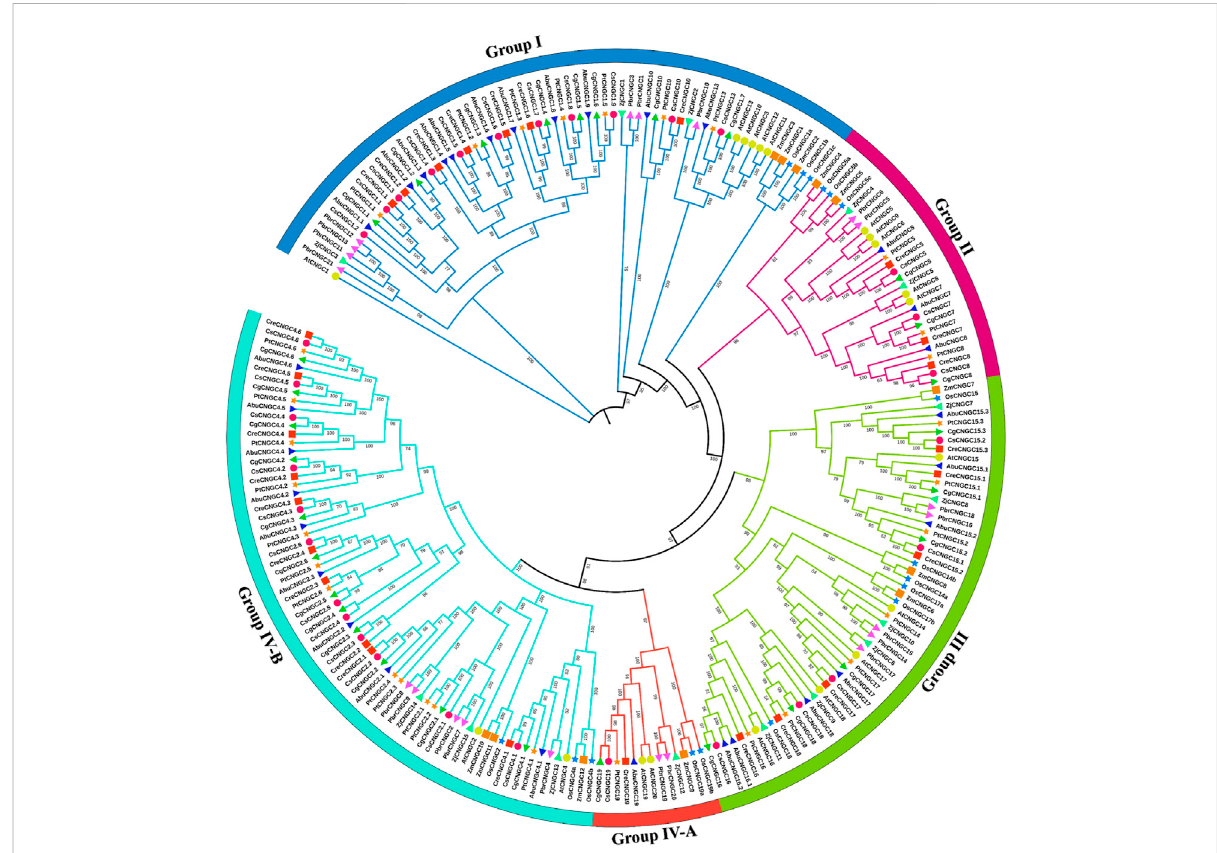
FIGURE 3 Phylogenetic relationship among AtCNGCs, OsCNGCs, ZjCNGCs, PbrCNGCs, ZmCNGCs, CsCNGCs, CreCNGCs, CgCNGCs, AbuCNGCs and PtCNGCs. The Multiple Sequence Alignment (MSA) has been done by using ClustalW. To build a phylogenetic tree, the IQ tree was utilized using the Maximum Likelihood method with 1,000 bootstrap replicates. Group names are indicated in front of each group. Different symbols are used to represent particular